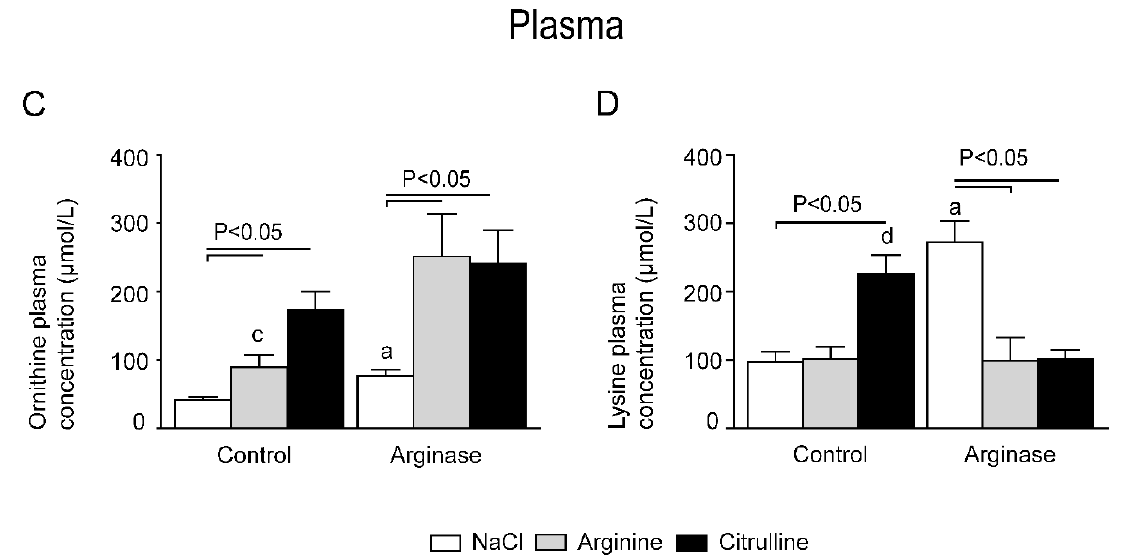
Figure 3. Effect of L -arginine or L -citrulline supplementation on plasma amino acid concentrations in control and arginase treated mice. ( A ) Plasma arginine concentrations during basal and arginase-treated conditions with or without citrulline or arginine; ( B ) plasma citrulline concentration in all treated groups; ( C ) ornithine concentrations during basal and arginase-treated conditions; ( D ) lysine concentrations in plasma were measured with HPLC. Plasma concentrations are displayed as μ mol/L. Significance: a p < 0.05 vs. control; b p < 0.05 vs. arginine; c p < 0.05 vs. arginine + arginase; d p < 0.05 vs. citrulline +